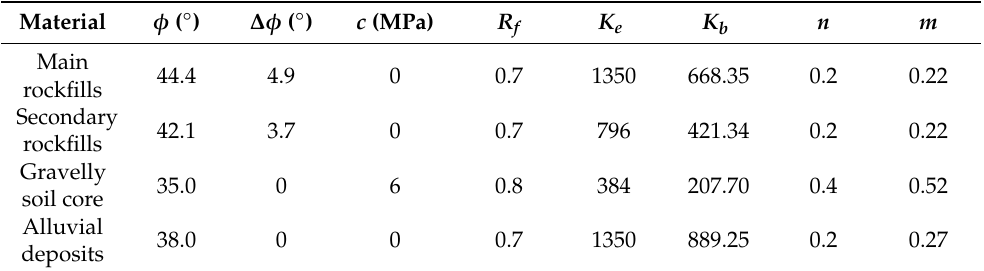
Table 3. Calibrated parameters of the creep deformation model for the materials in dam and foundation.